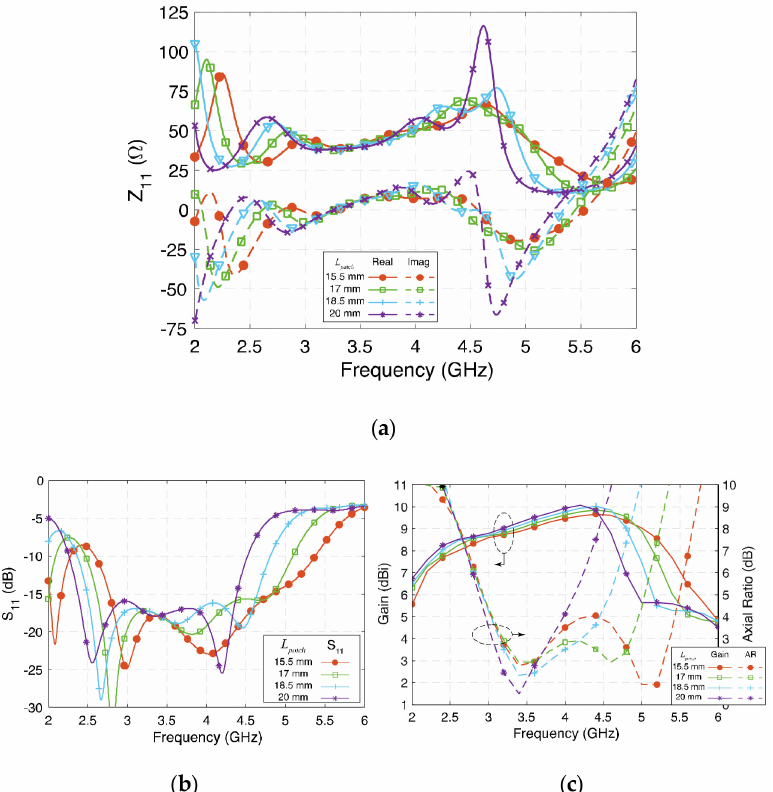
Figure 5. ( a ) Impedance (Z 11 ), ( b ) reflection coefficient (S 11 ), and ( c ) gain and axial ratio of the proposed antenna at different L patch